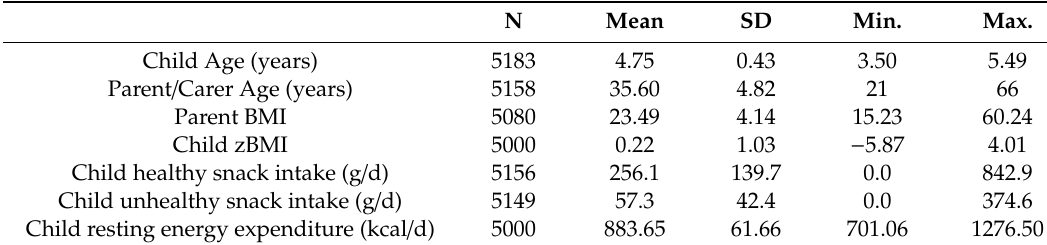
Table 3. Descriptive statistics for participant characteristics.